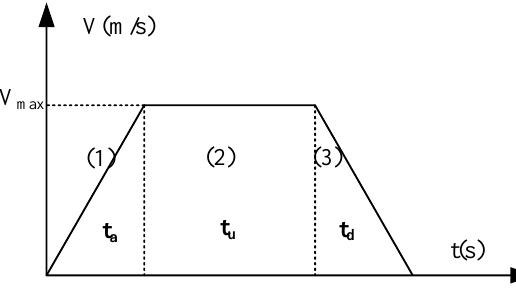
Figure 3. Velocity curve of low frequency motion.